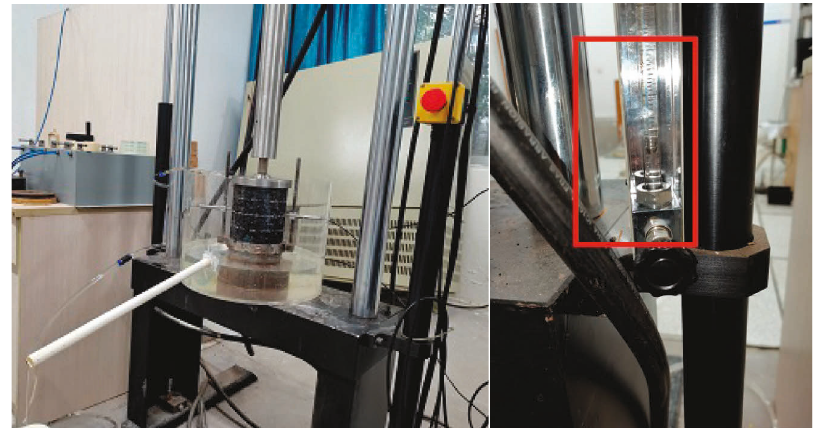
Figure 3: Seepage field-stress field coupling